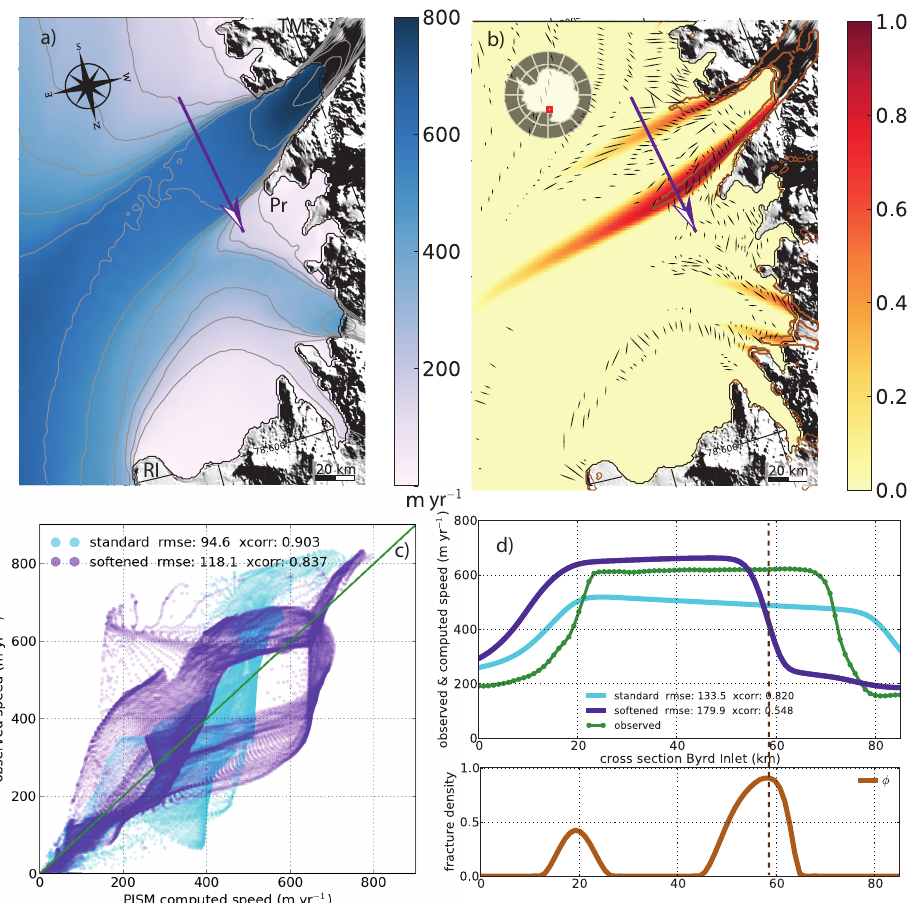
Fig. 8. Observed surface speed of the years 2003 and 2004 (a) and modeled steady-state fracture density φ (b) for the Byrd inlet region in western Ross Ice Shelf (violet box in Fig. 6a). In the lower panel values of observed (green) and calculated ice speed (blue and violet) as well as corresponding fracture density (brown) are plotted along indicated cross section. Parameters: FESOM-melting factor 0 . 2, E SSA = 0 . 05, γ = 0 . 2, σ cr = 110kPa, γ h = 0 . 05, ˙ (cid:15) h = 20 × 10 − 10 s − 1